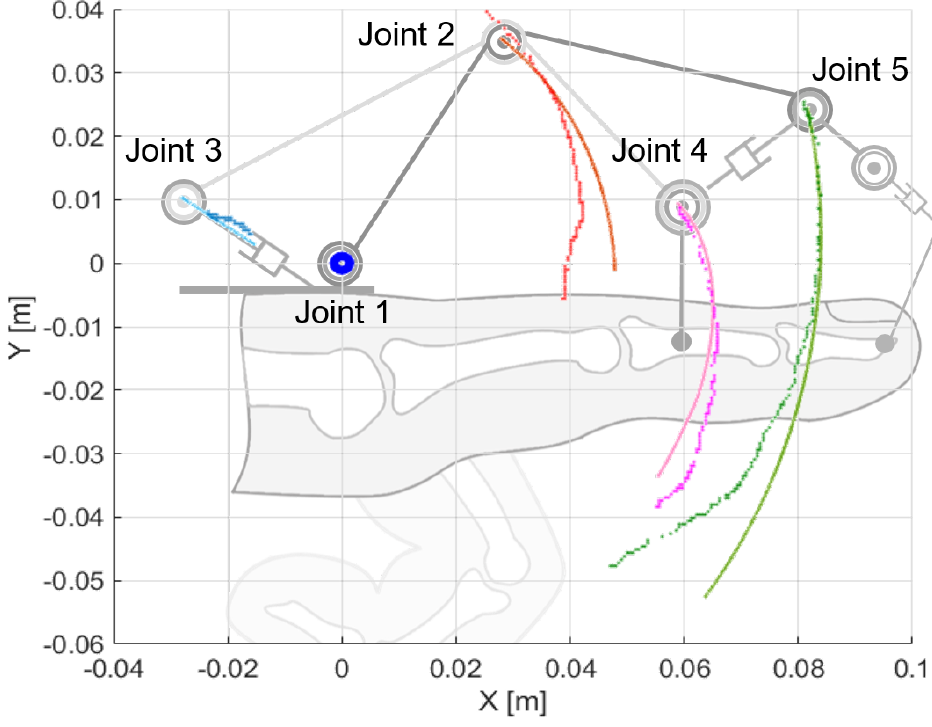
Figure 4. The figure shows the comparison between the trajectories of the joints of the exoskeleton generated by the kinematic model (solid lines) and the real ones (dashed lines) for the index